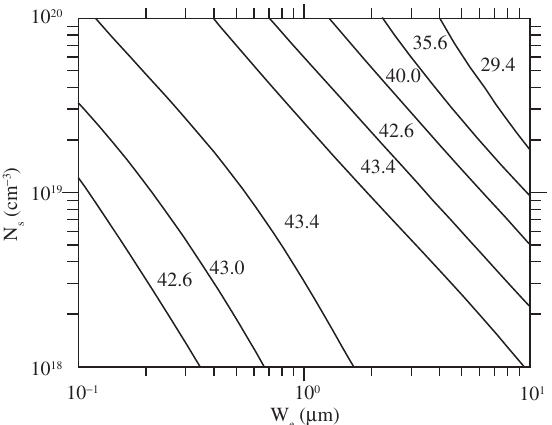
Figure 8. Solar cell efficiency contour plots, η (%) as a function of surface doping concentration, N base resistivity 1 Ω .cm.